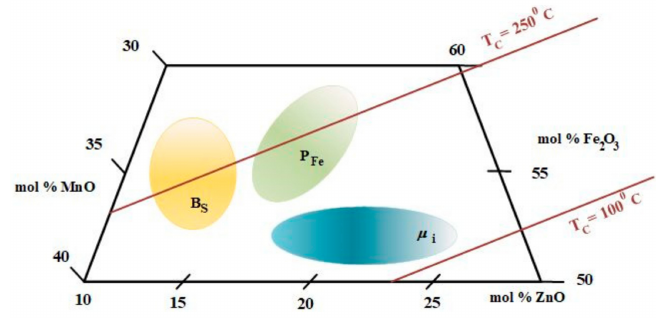
Figure 1. Composition diagram for MnZn ferrites, adapted from